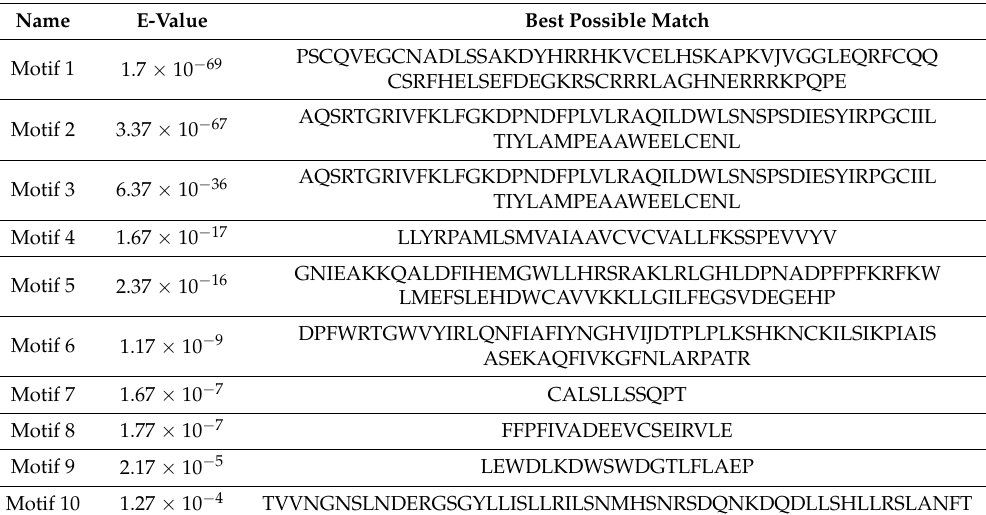
Table 3. Best possible match of conserved motifs.